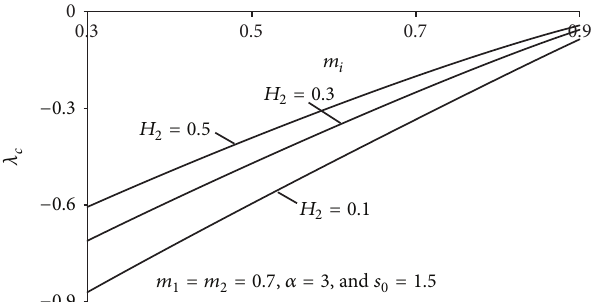
Figure 5: Variation of 𝜆 𝑐 with 𝑚 𝑖 at different values of 𝐻 2 (other input parameters are fixed).